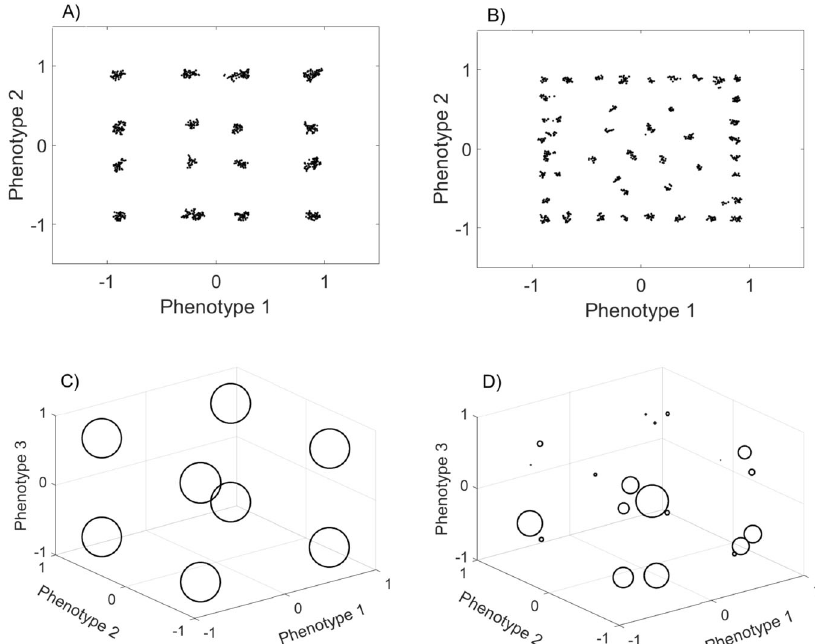
Fig. 2 Snapshots of cluster distributions. Distributions are shown for low (left column) and high (right column) β -values after 10 7 generations, for 2-dimensional (top row) and 3-dimensional (bottom row) phenotype spaces. A 16 species for β = 1, λ = 1.2, σ α = 0.5; B 47 species for β = 45, λ = 1.2, σ α = 0.5; C 8 species for β = 1, λ = 1.2, σ α = 0.75; D 20 species for β = 55, λ = 1.2, σ α = 0.75. The videos of various diversi fi cation scenarios corresponding to Fig. 2 can be found here: fi gshare.com/s/f2d8ecf480fa372319e1. In the top row panels and corresponding videos (2-dimensional case), all phenotypes present in the evolving community are shown (represented as dots). In the bottom row panels and corresponding videos (3-dimensional case), species resulting from clustering of populations of similar phenotypes using a merging distance of Δ x species = 10 − 1 (see second section of Methods) are represented by circles whose size is proportional to a species' population size.